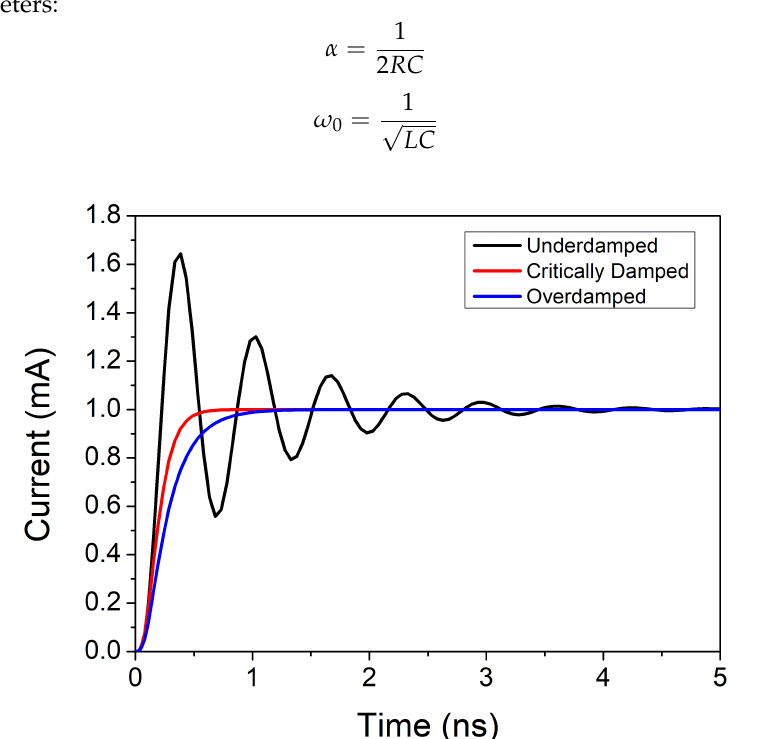
Figure 4. Step response of an resistor-inductor-capacitor (RLC) parallel